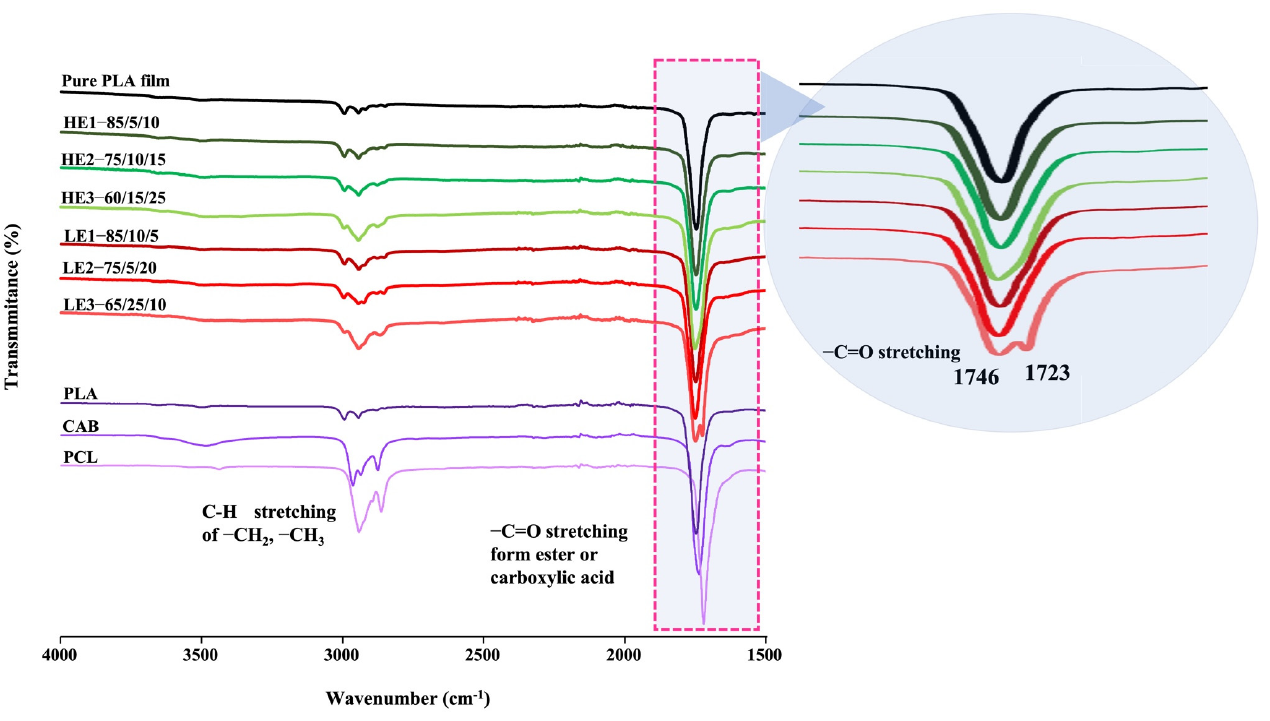
Figure 4. FTIR spectra of ternary-blended, melt-blown films of PLA/PCL/CAB at different compo- sitions.